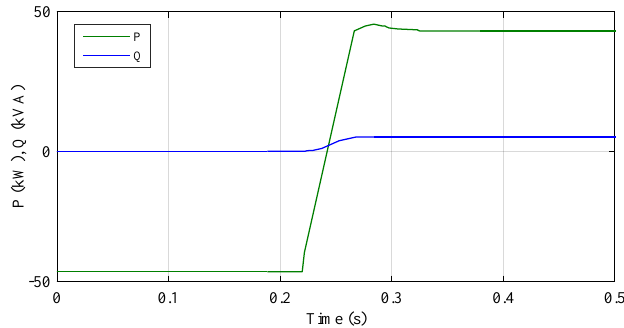
Figure 18. V2G operation for reactive power compensation: reactive power ( top ), active power ( bottom